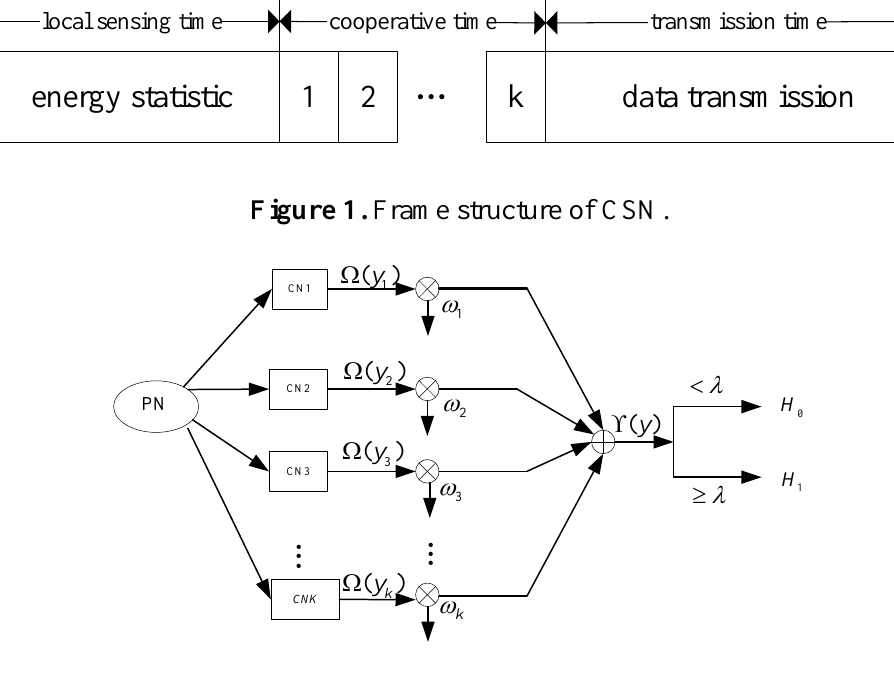
Figure 2. Weighed cooperative spectrum